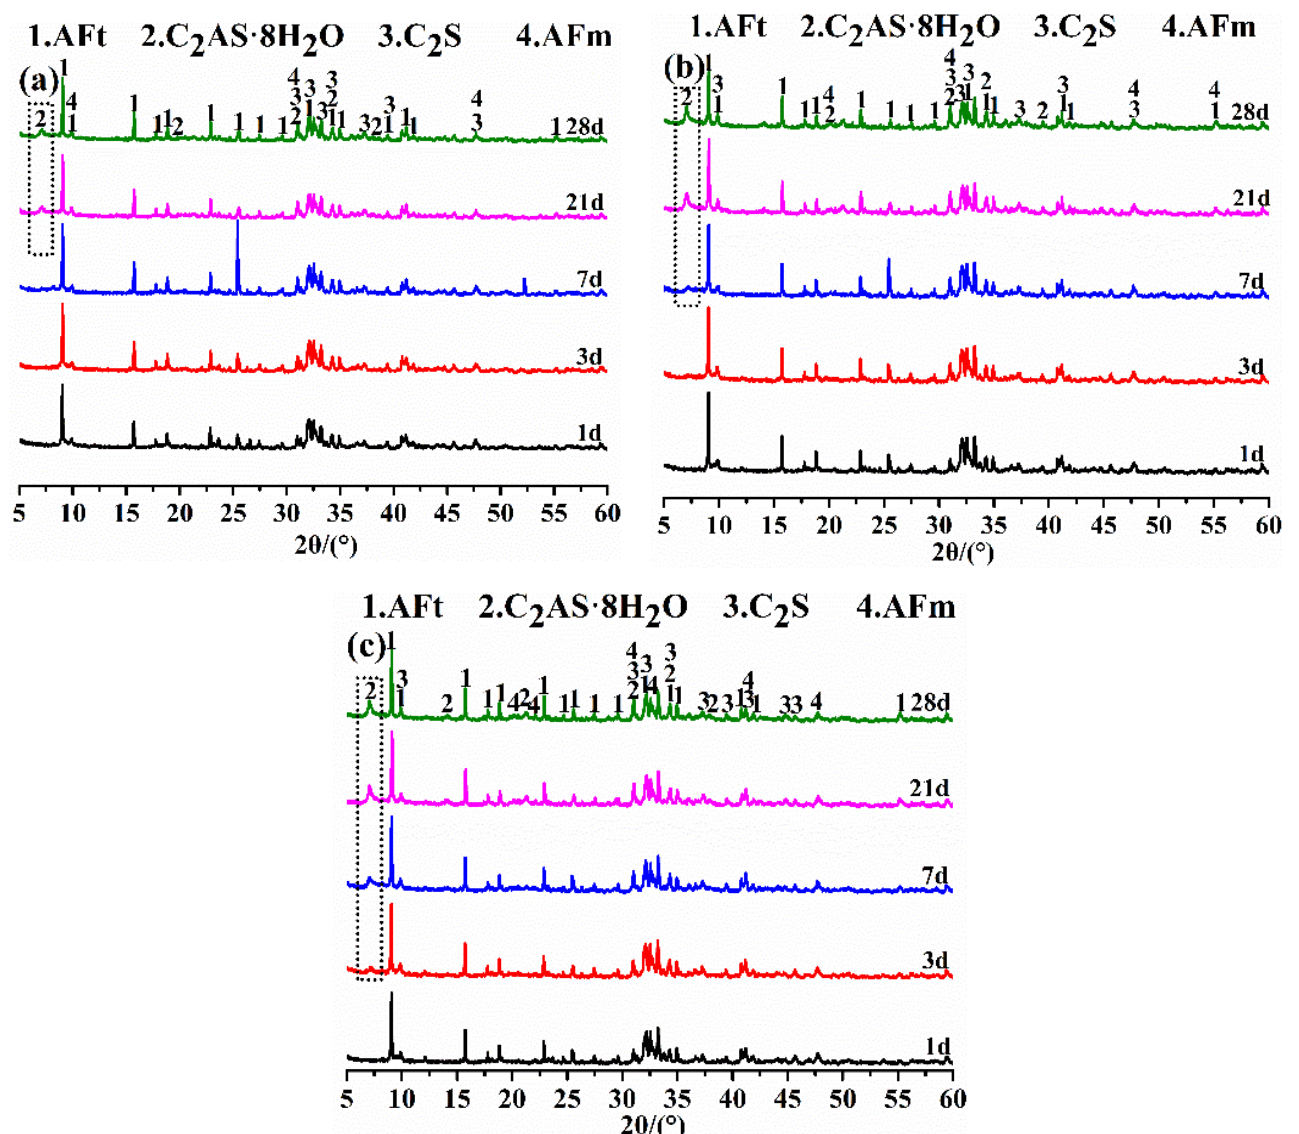
Figure 4. The XRD patterns of the BBSC hydration products: ( a ) GF-1, ( b ) GF-2, and ( c ) GF-3. The ESEM images of BBSC after curing for different times are shown in Figure 5.